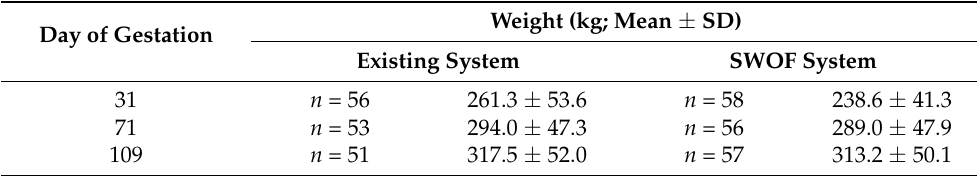
With n = number of focus sows weighed.